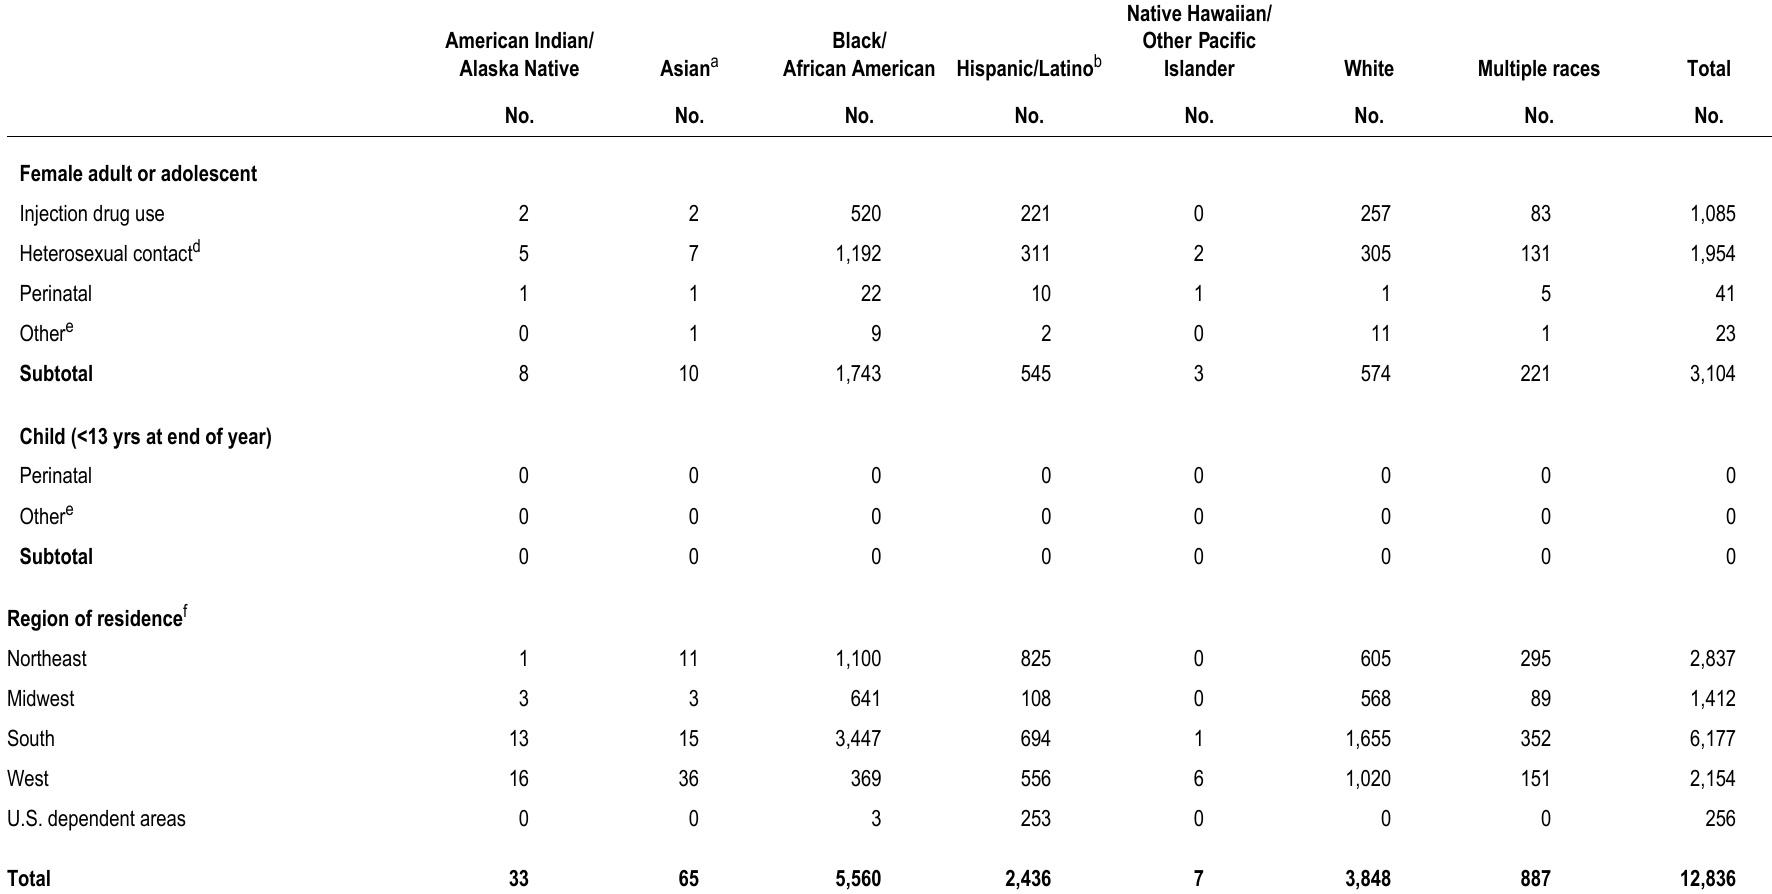
Table 21b. Deaths of persons with diagnosed HIV infection ever classified as stage 3 (AIDS), by race/ethnicity and selected characteristics, 2017—United States and 6 dependent areas